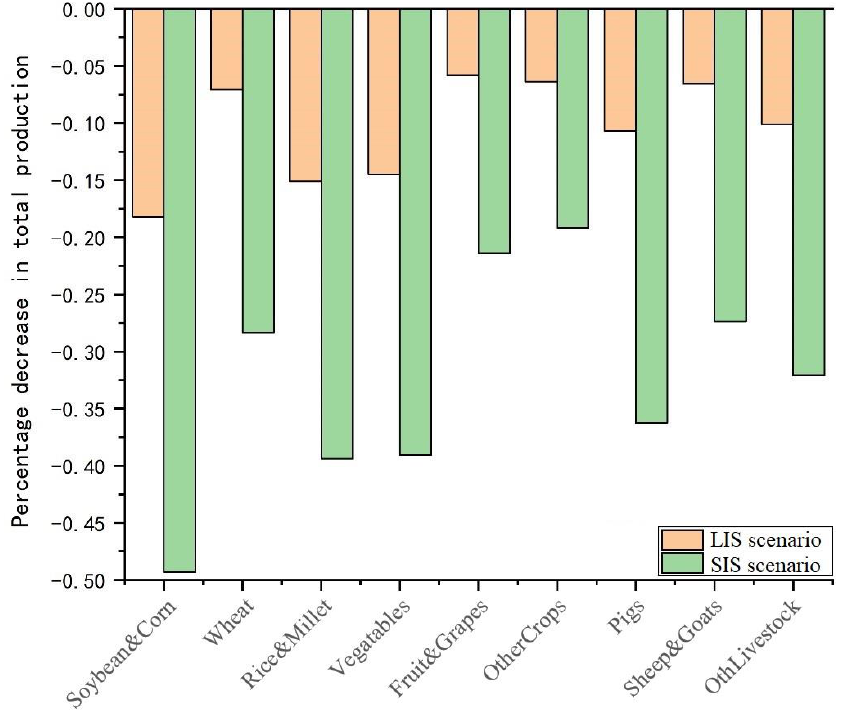
Figure 2. Change in national agricultural production output under different